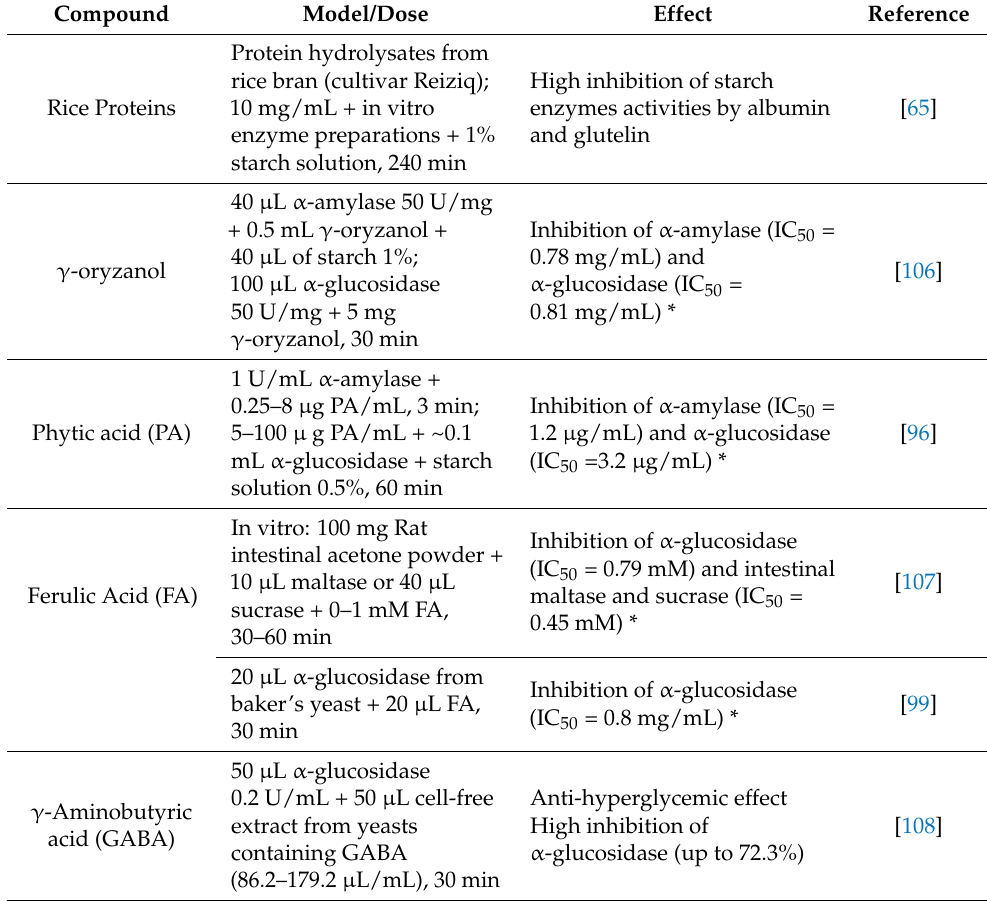
Table 5. Effect of macronutrients and bioactive rice compounds in α -amylase and α -glucosidase activities. Compound Model/Dose Effect